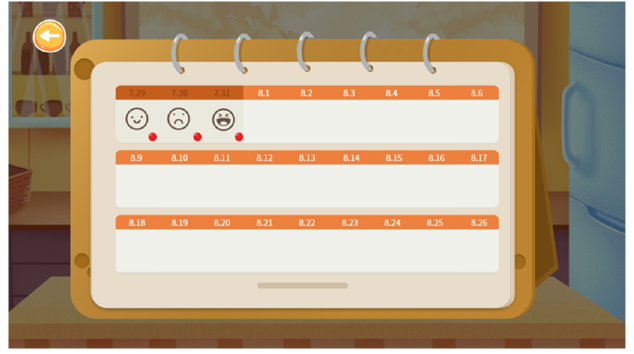
Figure 3. Screenshot of the mood calendar.